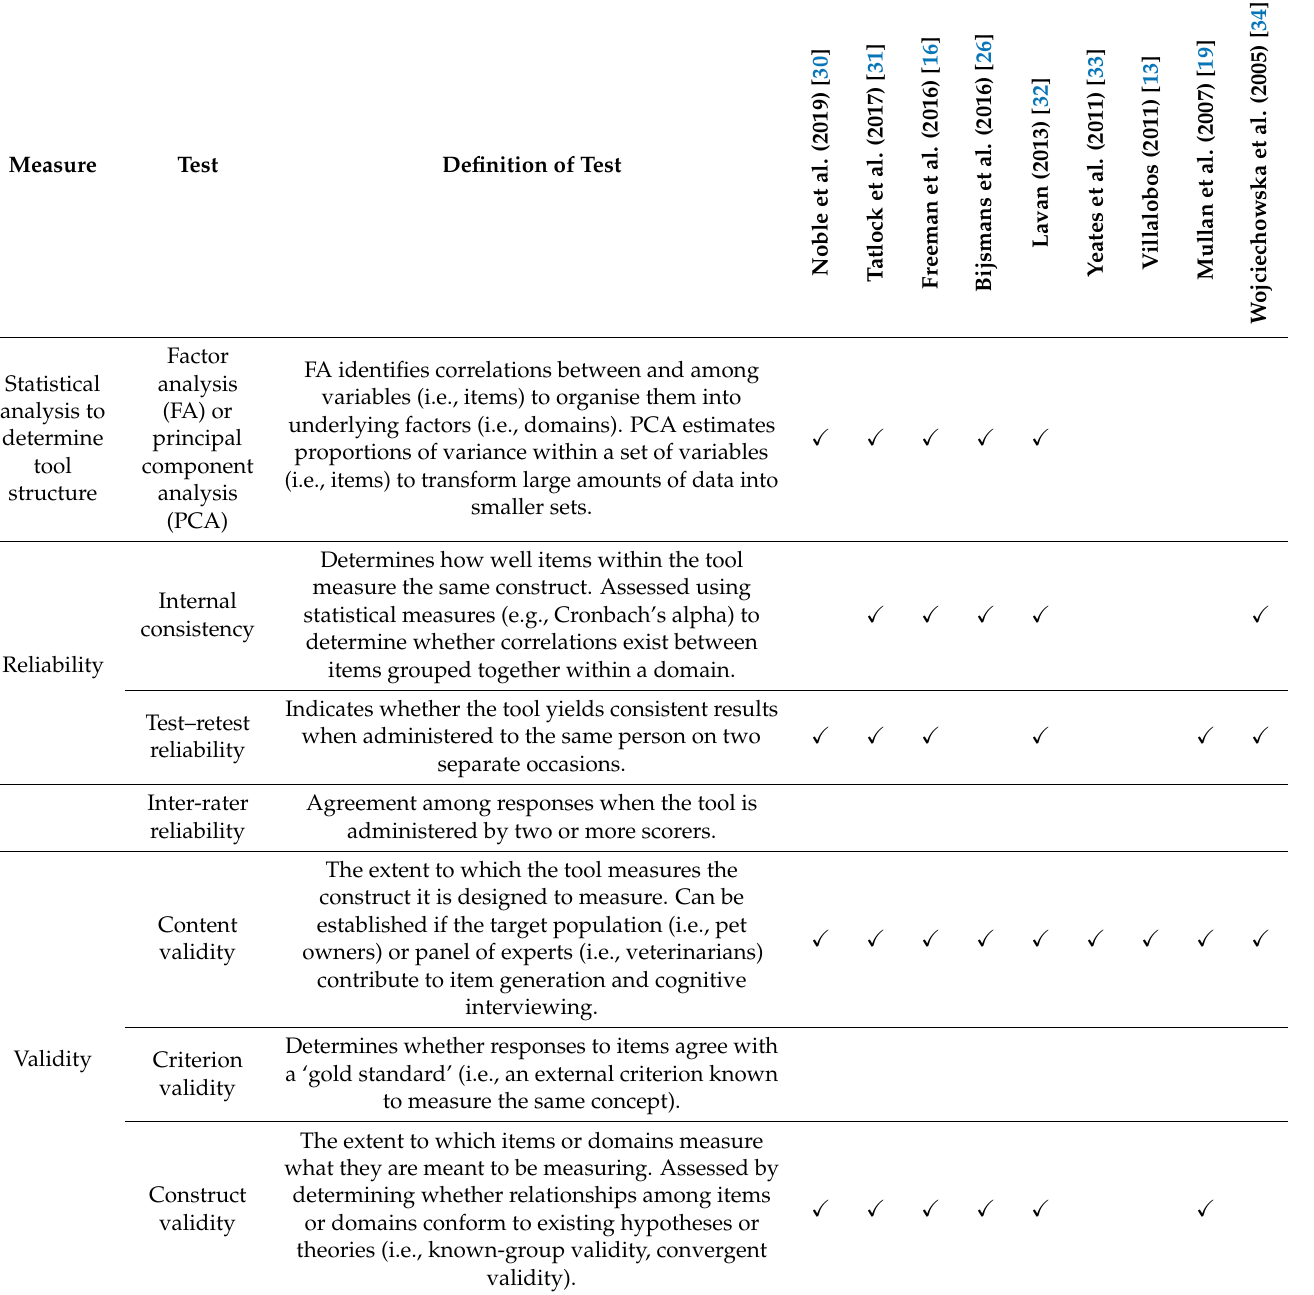
Table 1. Assessment of psychometric properties including statistical analysis, reliability and validity of the nine published QoL tools (adapted from the United States Food and Drug Administration